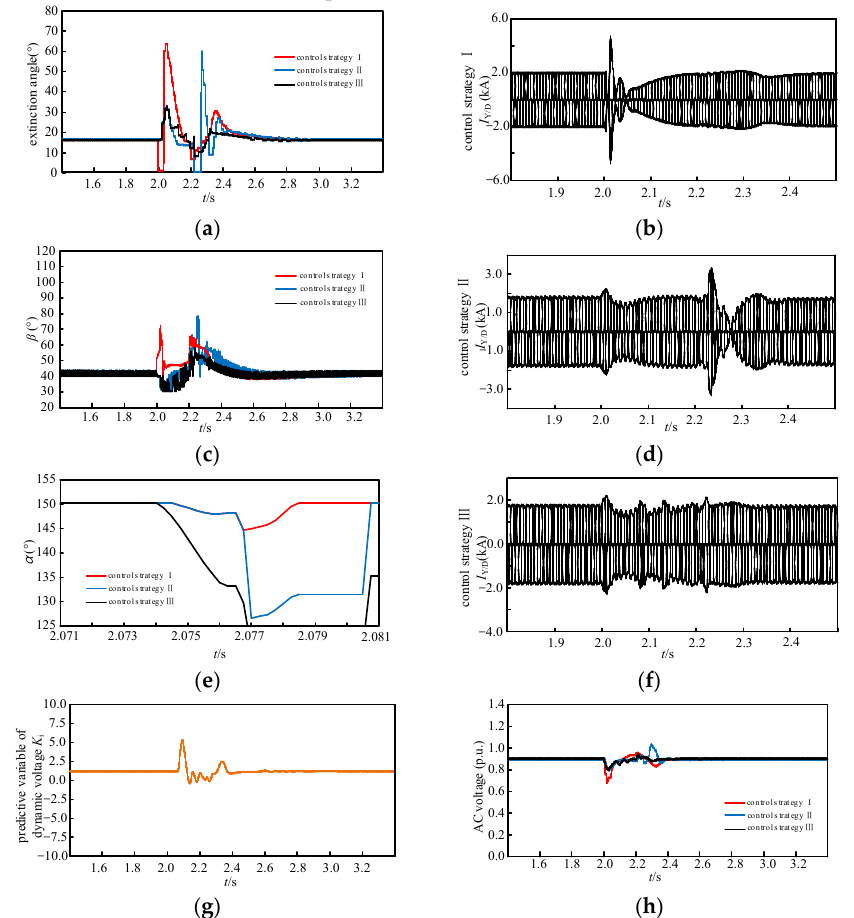
Figure 11. Waveforms of three-phase short-circuit fault under different strategies. ( a ) Extinction angle γ under three strategies. ( b ) Current at valve side of converter transformer under strategy I. ( c ) Trigger advance angle β under three strategies. ( d ) Current at valve side of converter transformer under strategy II. ( e ) Trigger delay angle α under three strategies. ( f ) Current at valve side of converter transformer under strategy III. ( g ) Predictive variable of dynamic voltage K i . ( h ) AC voltage at inverter